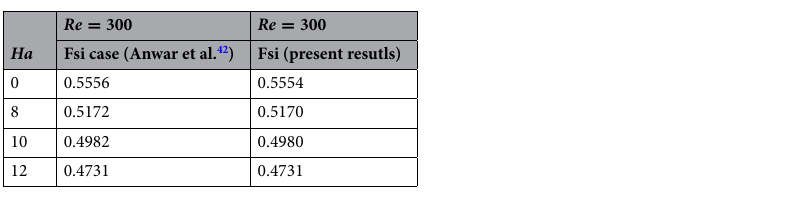
Table 2. Velocity magnitude